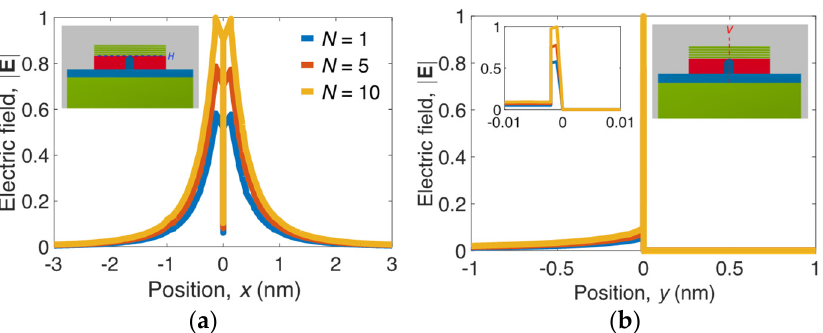
Figure 5. Electric fields, | E | along the ( a ) horizontal dashed line H and ( b ) vertical dashed line V shown in the corresponding insets for N = 1, 5, and 10.